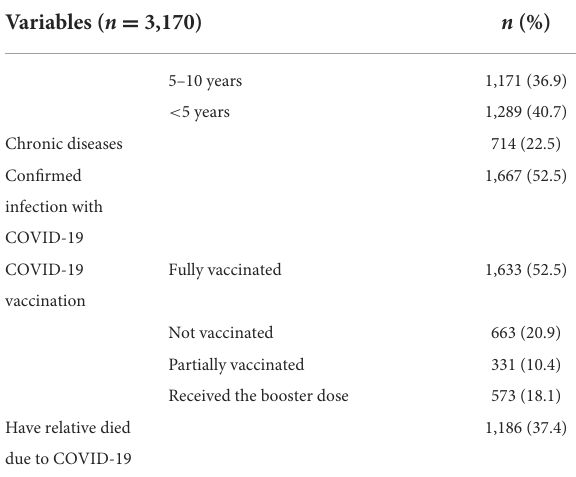
TABLE 1 Sociodemographic and health related characteristics of the study